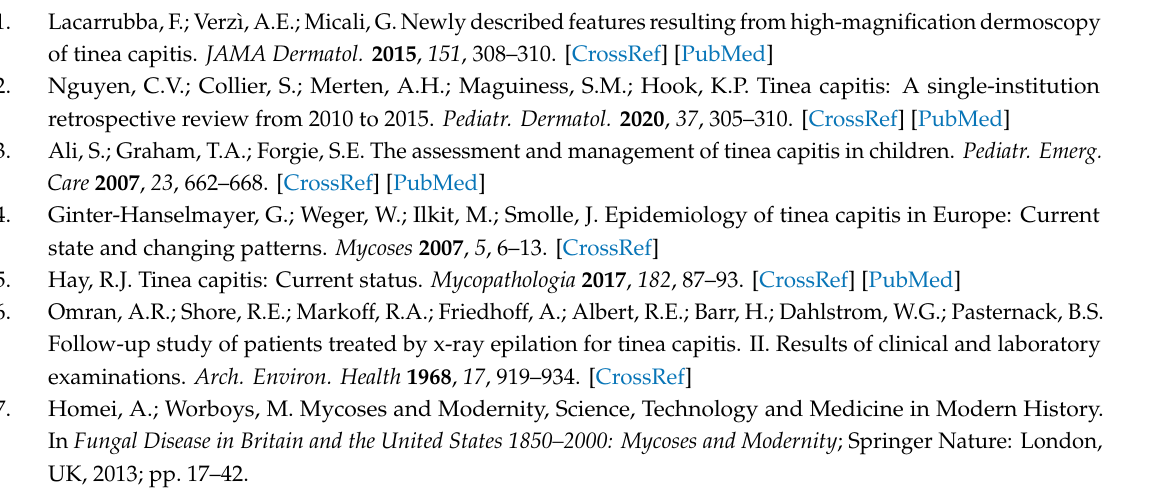
Table S1. Rates of health problems among women with hair loss compared to women in the general population in